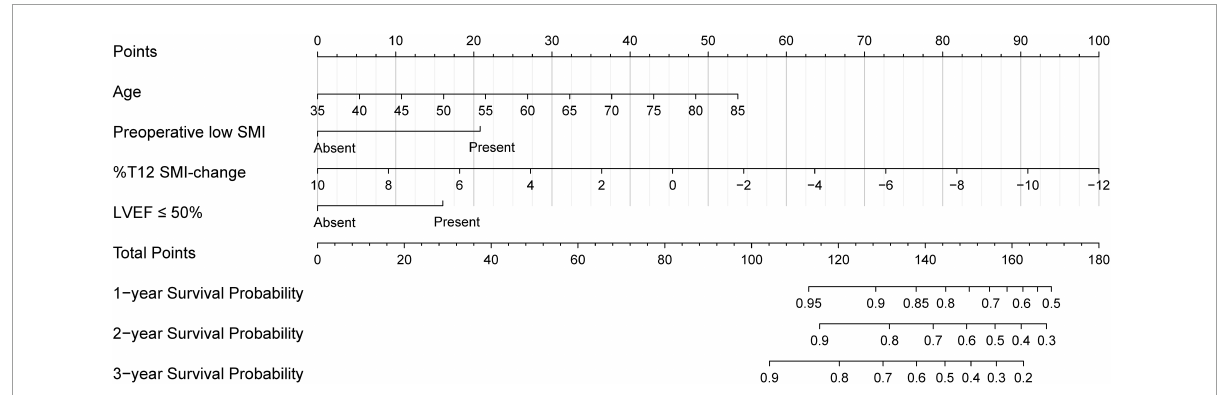
FIGURE4 The nomogram developed to predict the overall survival. SMI, skeletal muscle index; %T12 SMI-change, T12 SMI percent change; LVEF, left ventricular ejection.